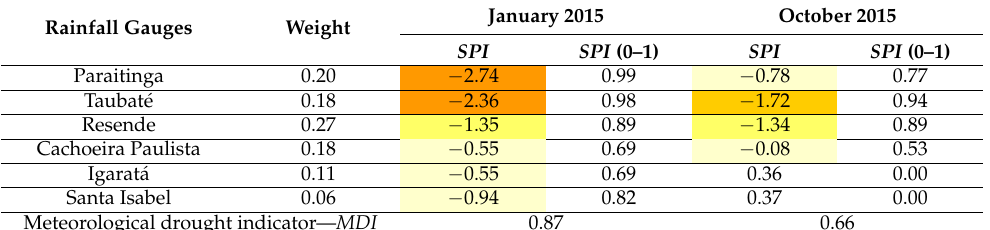
Figure 7. SPI index of rainfall gauges in the region (January 2015).